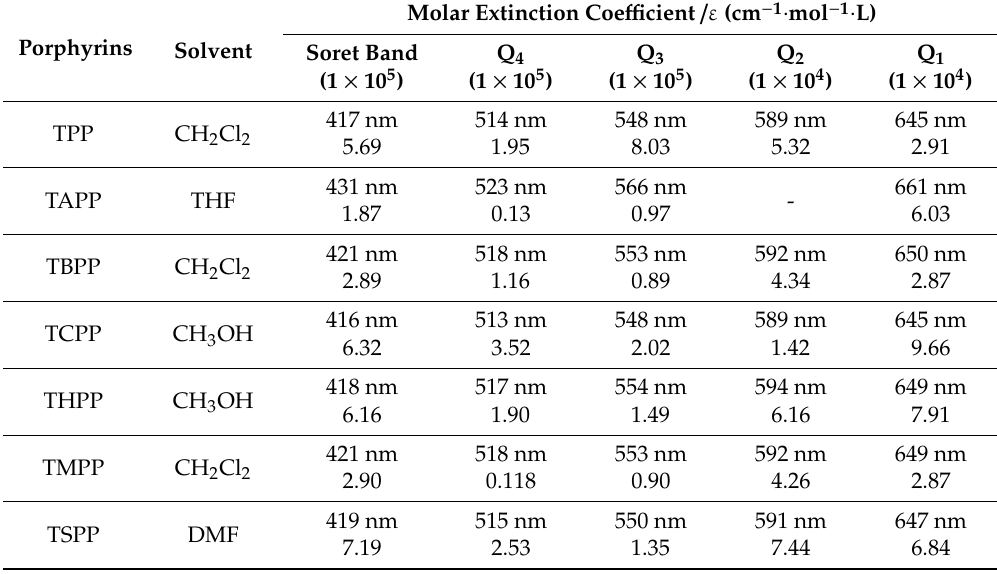
Table 2. Molar extinction coe ffi cient ( ε ) results calculated at each band in corresponding solution